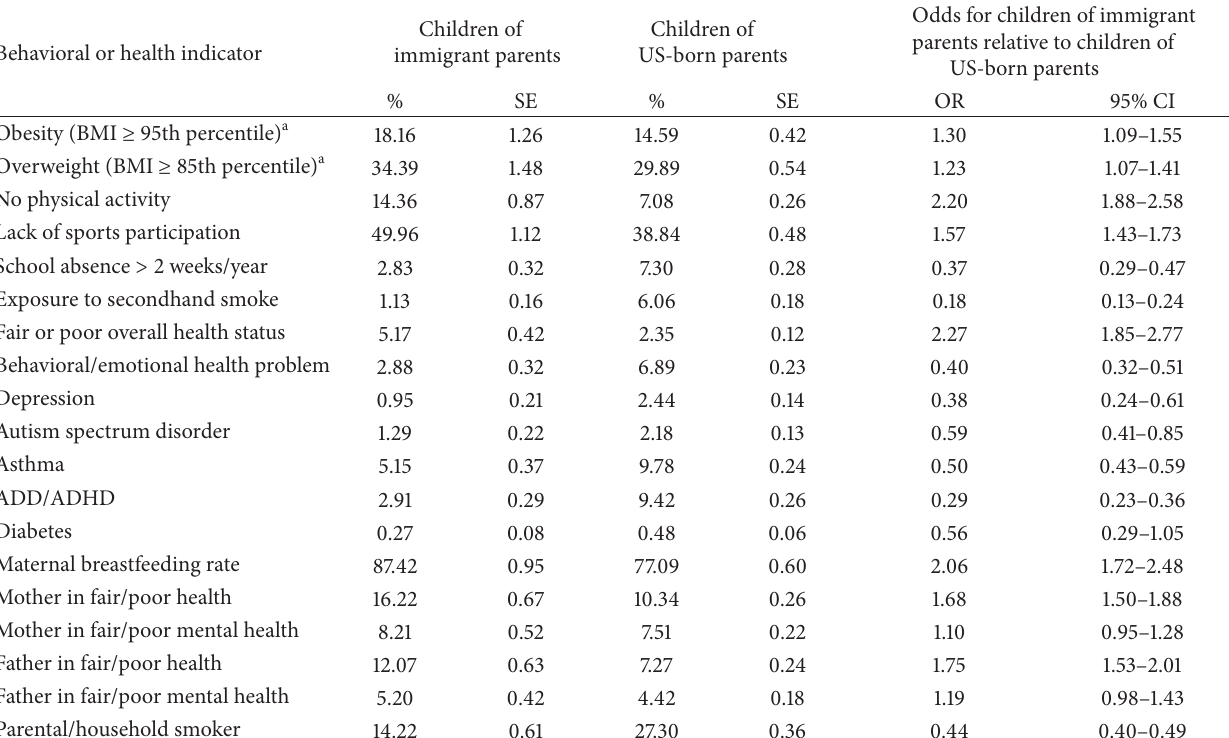
Table 4: Weighted prevalence (%) and unadjusted odds ratios for selected behavioral and health indicators among children aged < 18 years born to immigrant and US-born parents: The 2011-2012 National Survey of Children’s Health ( 𝑁 = 95